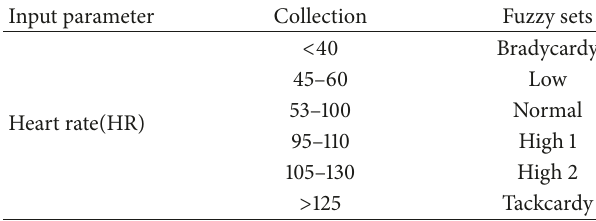
Table 4: The range of heart rate input parameter.